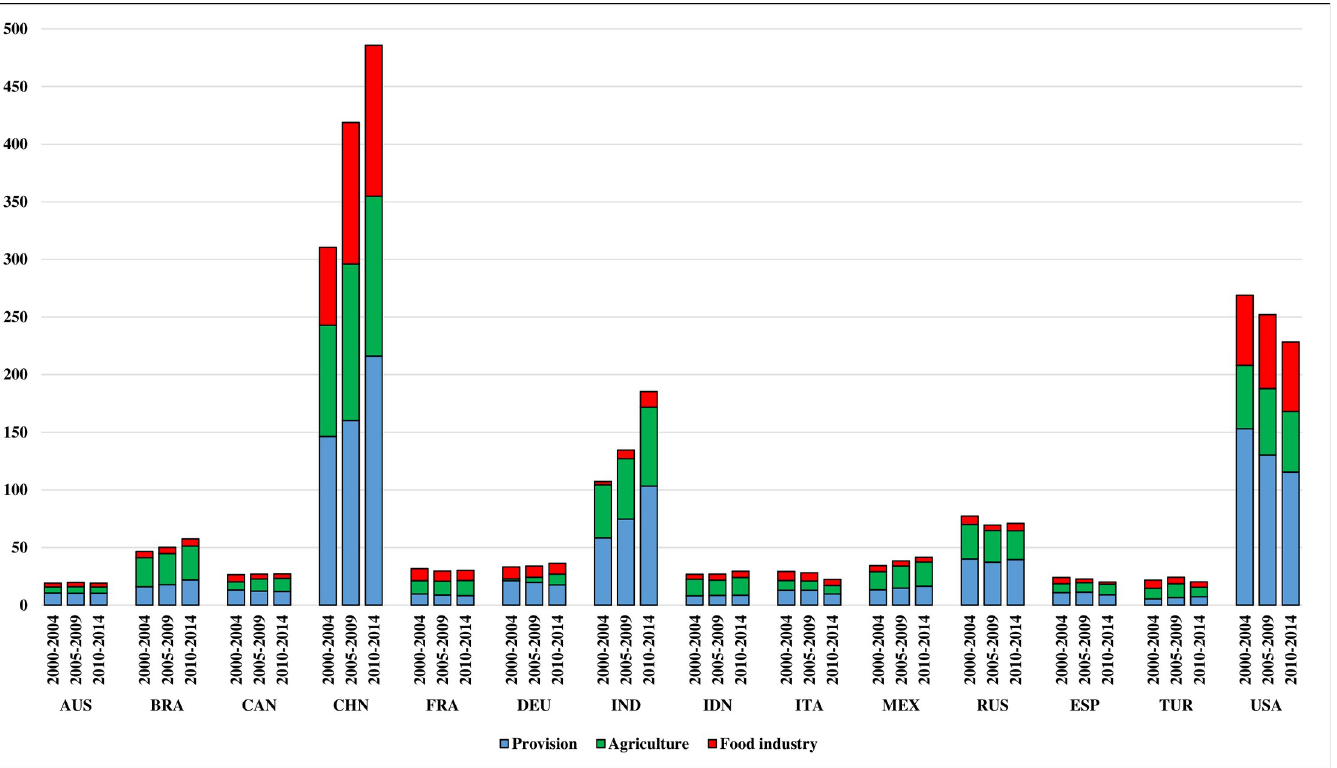
Fig 1. Average food production system carbon dioxide (CO 2 ) emissions in megatonnes in the examined countries. Source: Authors’ calculations based on data from WIOD Environmental Accounts (Update 2000–2016) and WIOD, Release